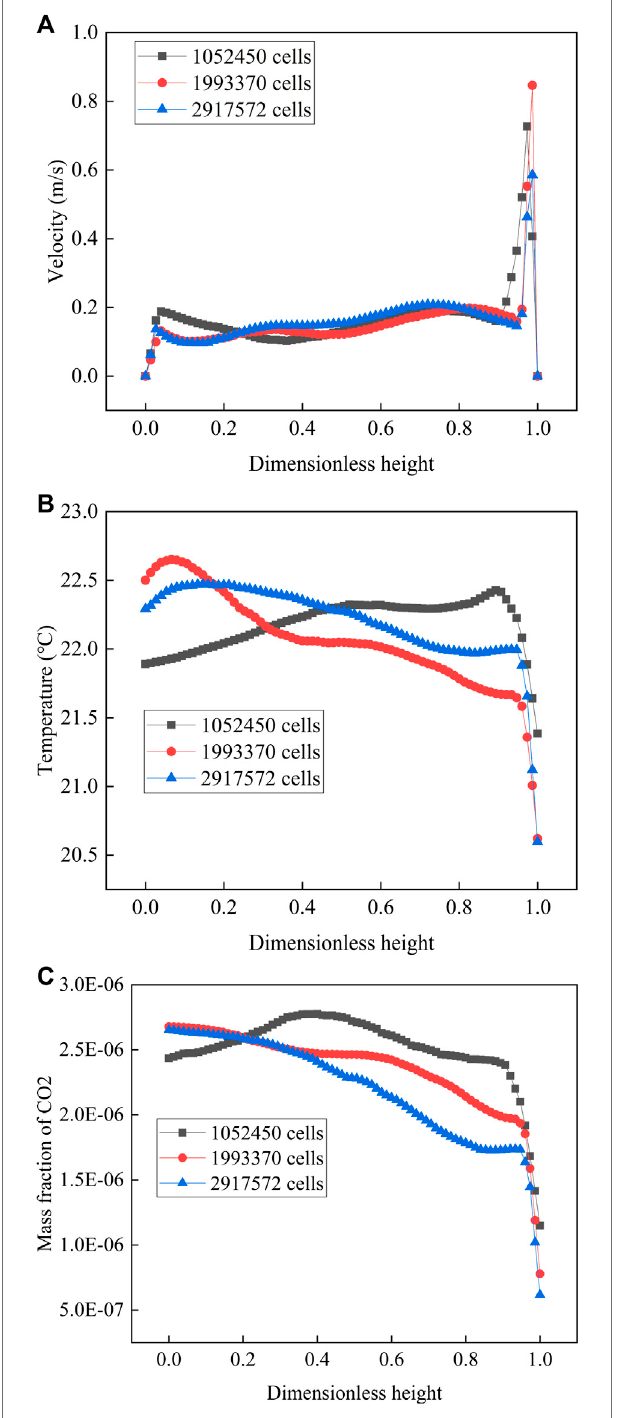
FIGURE 3 | Comparison between different numbers of grids along Line 1: (A) variationofvelocity; (B) variationoftemperature; (C) variationofmassfraction.